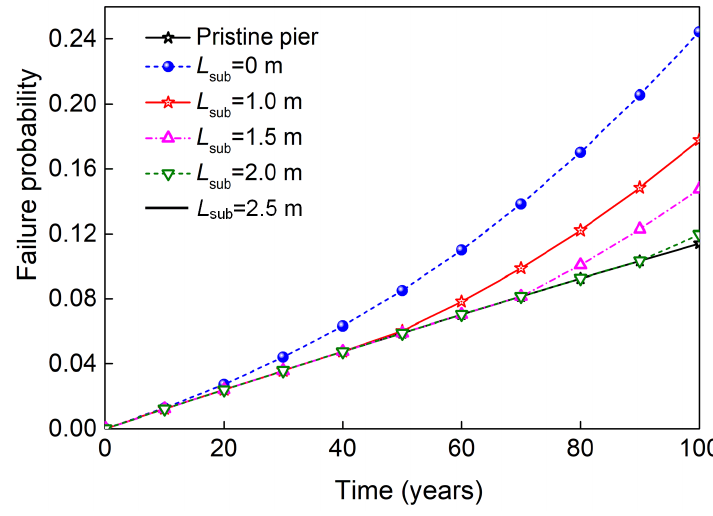
Figure 17. Time-dependent failure probability of the whole